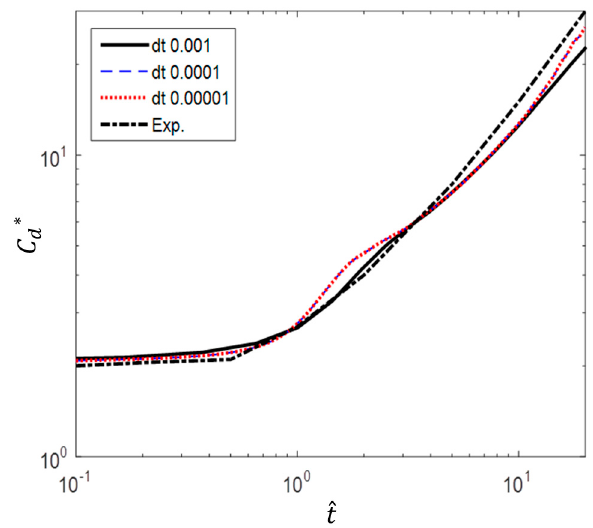
Figure 6. Comparison of different turbulence models (experimental data from Sarpkaya and Garrison